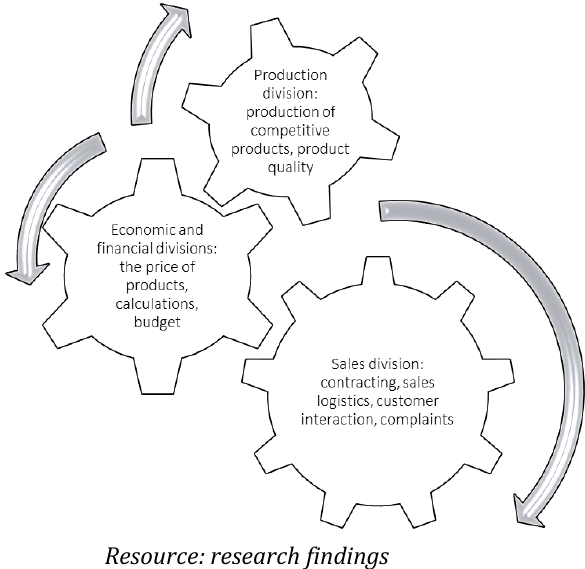
Figure 1: Interaction of enterprise divisions in achieving strategic goals of enterprise